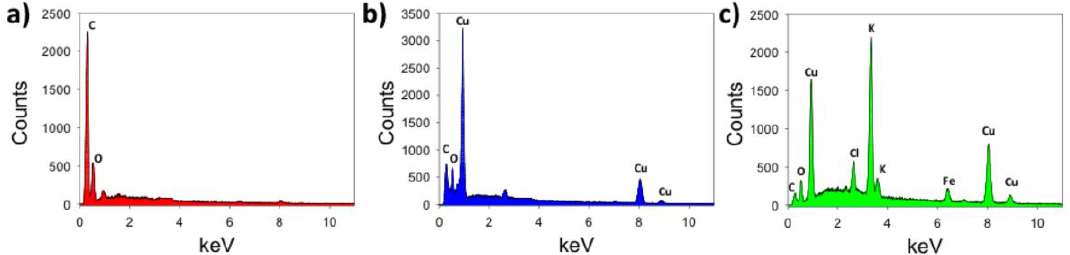
Figure 4. EDS spectra of LSG before and after metallization. ( a ) LSG after graphitization at 1.7 J/cm 2 , showing formation of graphitized carbon; ( b ) EDS spectra of the urchin structure shown in the inset of Figure 2b; ( c ) EDS spectra of nodules along large mesotube structures shown in the inset of Figure 2c.